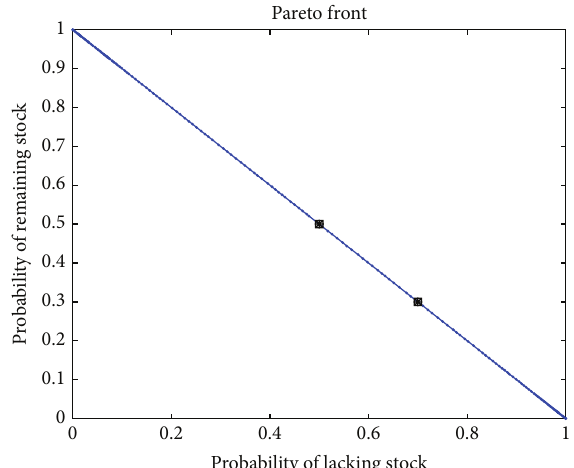
Figure 3: Case 1, box-plots for first product inventory levels when ordering by the median.